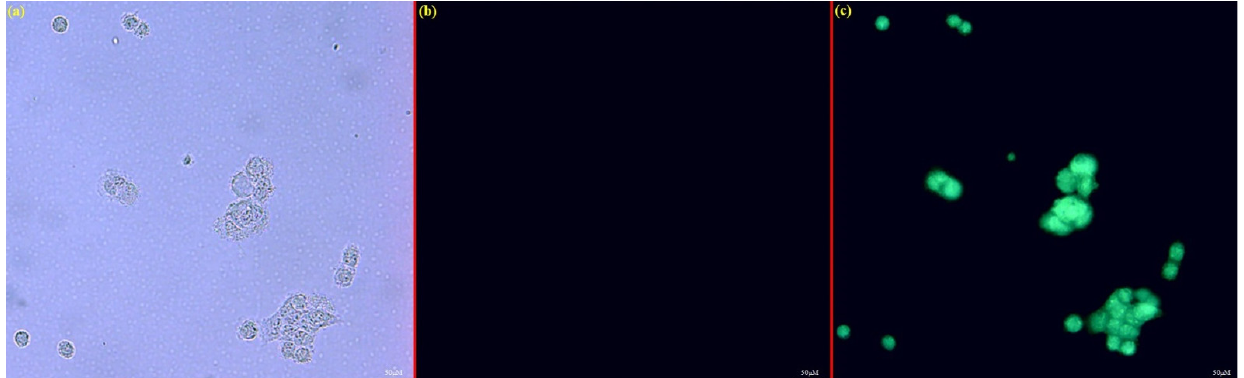
Figure 11. Images of HSC cells: cells themselves, ( a ) bright field, only incubated with 10 µM BHMMP ; ( b ) fluorescence treated with 10 µM BHMMP, followed by addition of 50 µM Al 3+ ; ( c ) fluorescence.